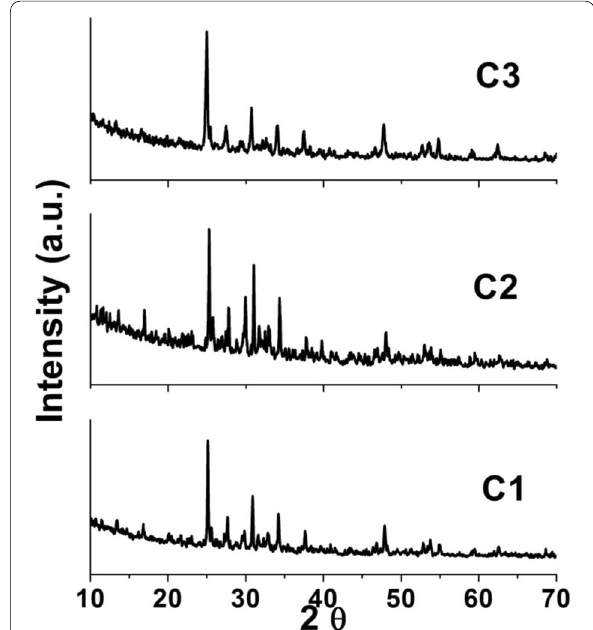
Fig. 4 XRD patterns of the prepared ceramic